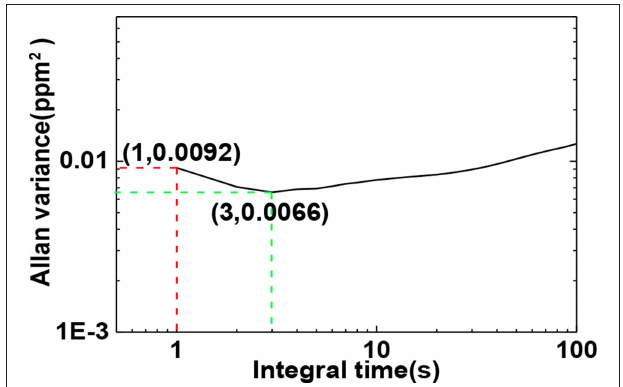
FIGURE 13 | Allan